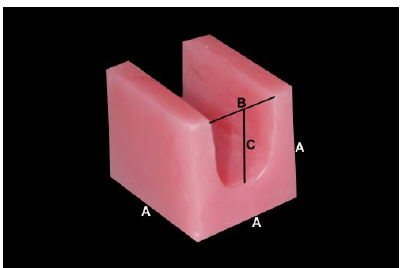
Figure 3. Square specimen with U ‐ shaped profile made from PMMA ( A = 25 mm, B = 13 mm, C = 18 mm).